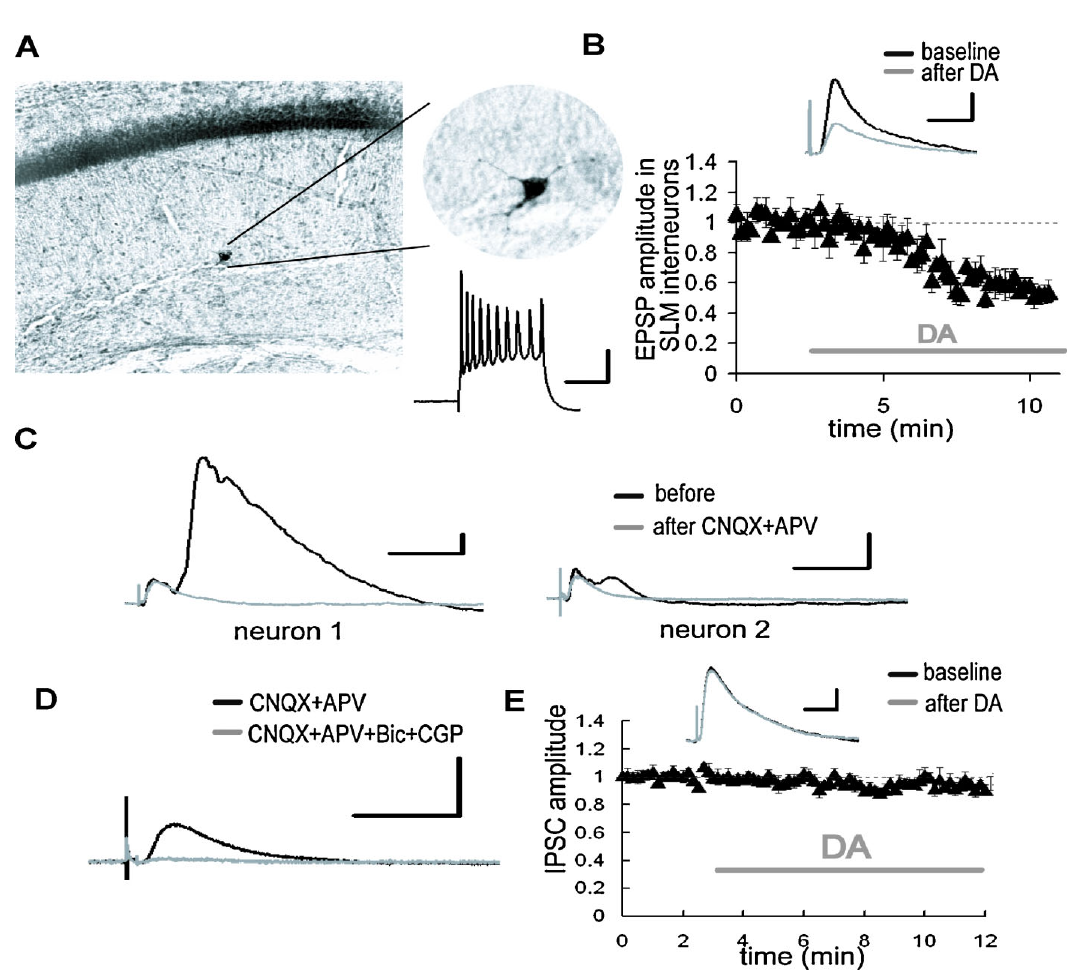
Figure 2. DA-induced depression of excitatory inputs to SLM interneurons . ( A ) Intracellular recording from SLM interneurons. Biocytin-filled electrodes were used for the staining of SLM interneurons. The inset shows representative spike activities following current injection. Scale bar = 50ms, 20mV. ( B ) After DA application, the EPSP evoked by the TA pathway stimulation was significantly depressed. p<0.01 (n = 5). Scale bar = 1mV, 20ms. ( C ) Whole-cell voltage-clamp recordings from CA1 pyramidal neurons at a holding potential of 0mV. The late component of the IPSC disappeared after excitatory blockade with CNQX (10 µ M) and APV (25 µ M). The size of late IPSC showed large variability among recorded neurons. Scale bar = 50pA, 100ms. ( D ) The monosynaptic IPSC was